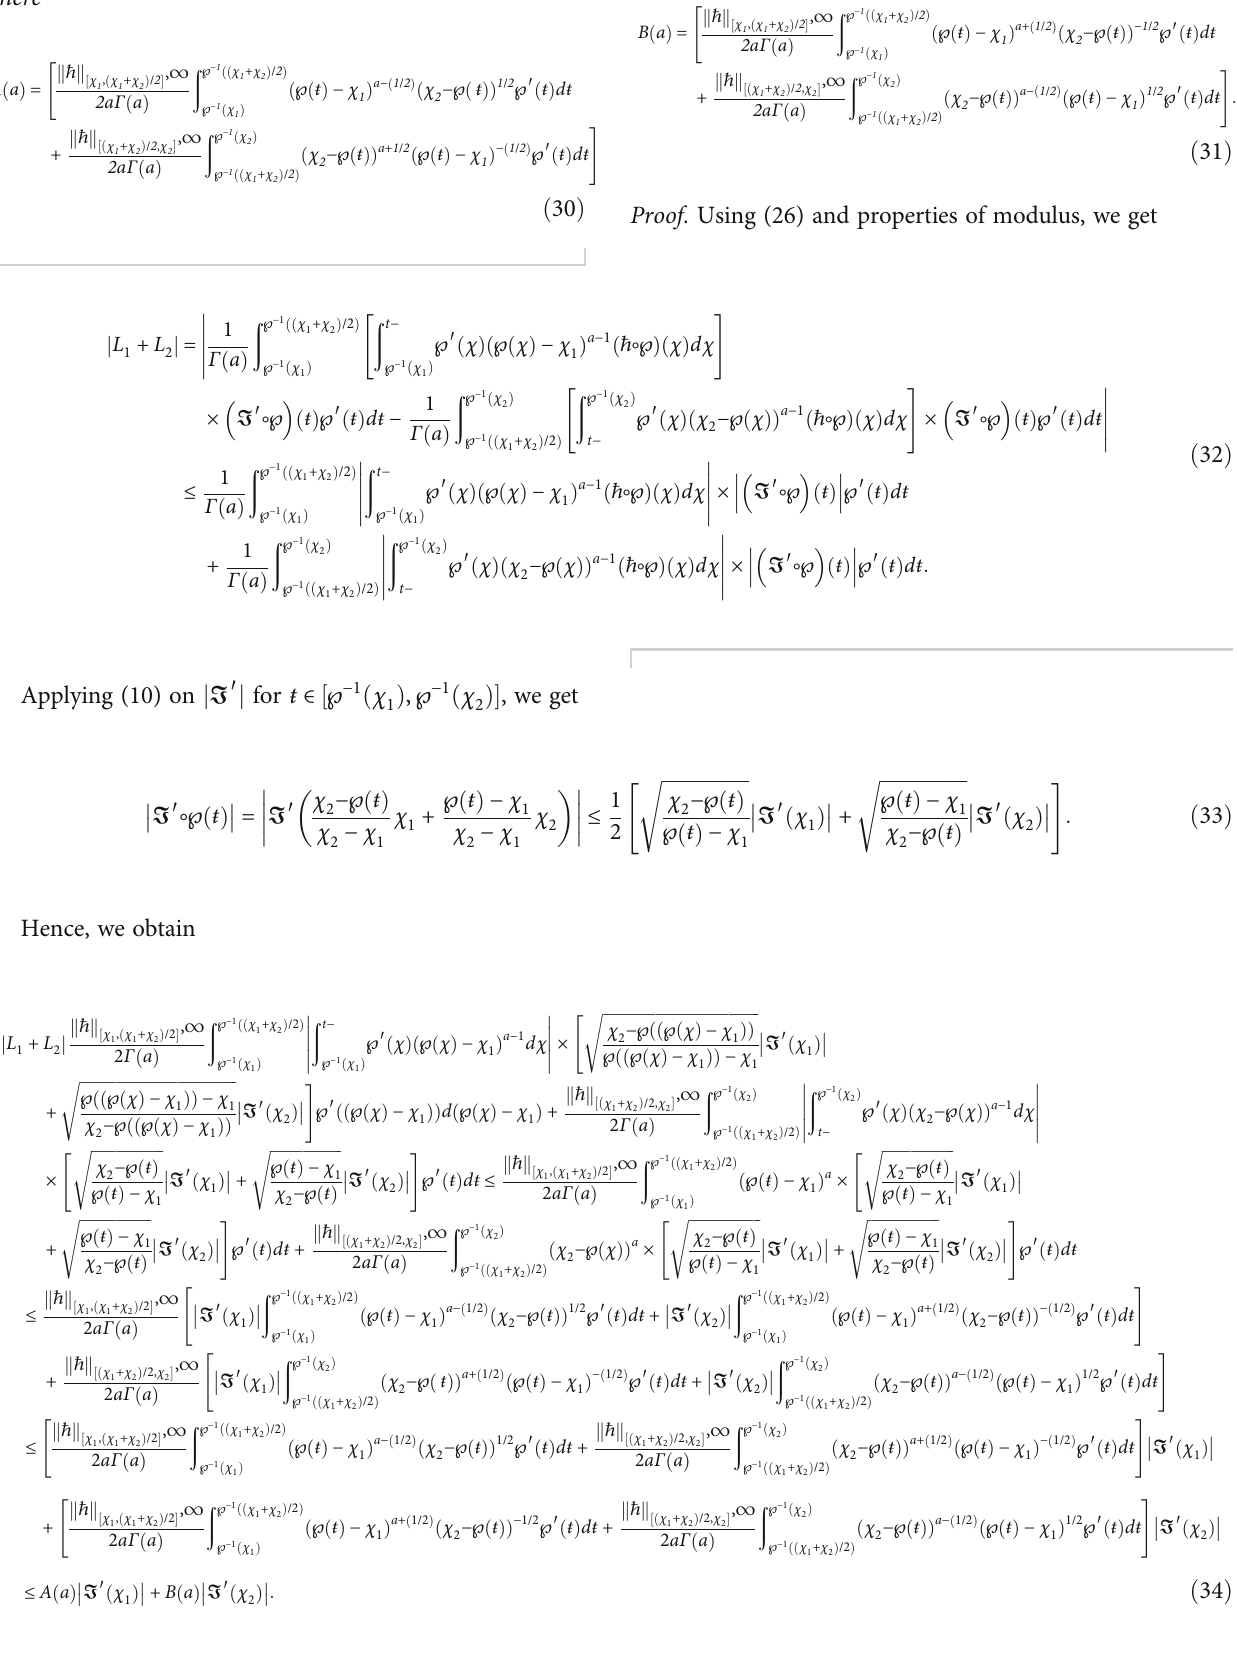
ffiffiffiffiffiffiffiffiffiffiffiffiffiffiffiffiffiffi χ − ℘ ŧ ð 2